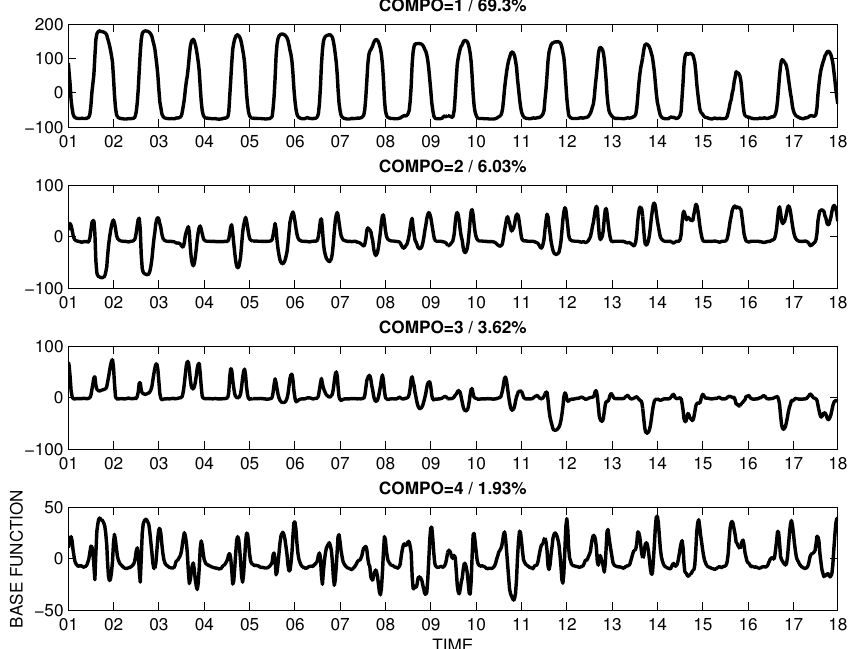
Figure 5. The first four temporal Principal Component Analysis (PCA) base functions of the MODIS inundation associated to the spatial patterns in Figure